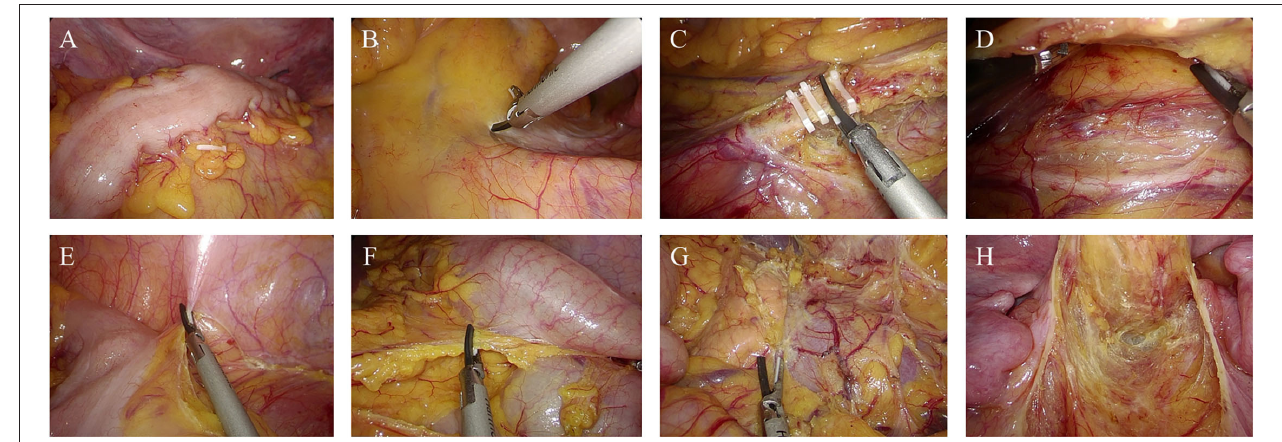
FIGURE 1 | Abdominal phase of the first stage of PE-Bacon procedure. (A) Mark at the proximal site of non-irradiated colon. (B) Incise the mesentery of sigmoid along the sacral promontory. (C) Ligate inferior mesenteric vessels. (D) Expand the Toldt’s fascia. (E,F) Mobilize the colon toward the splenic flexure. (G) Dissect the phrenicocolic ligament and splenocolic ligament. (H) Mobilize the rectum.